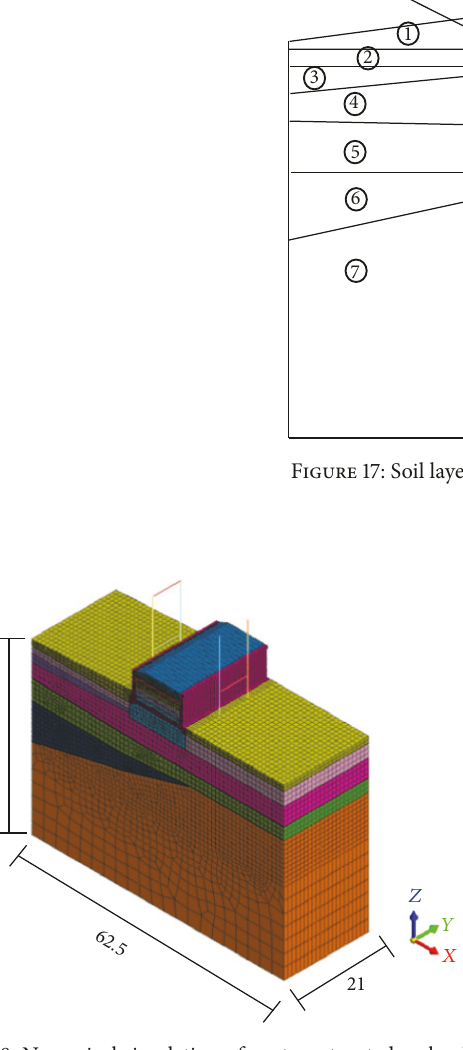
Figure 18: Numerical simulation of postconstructed embankment